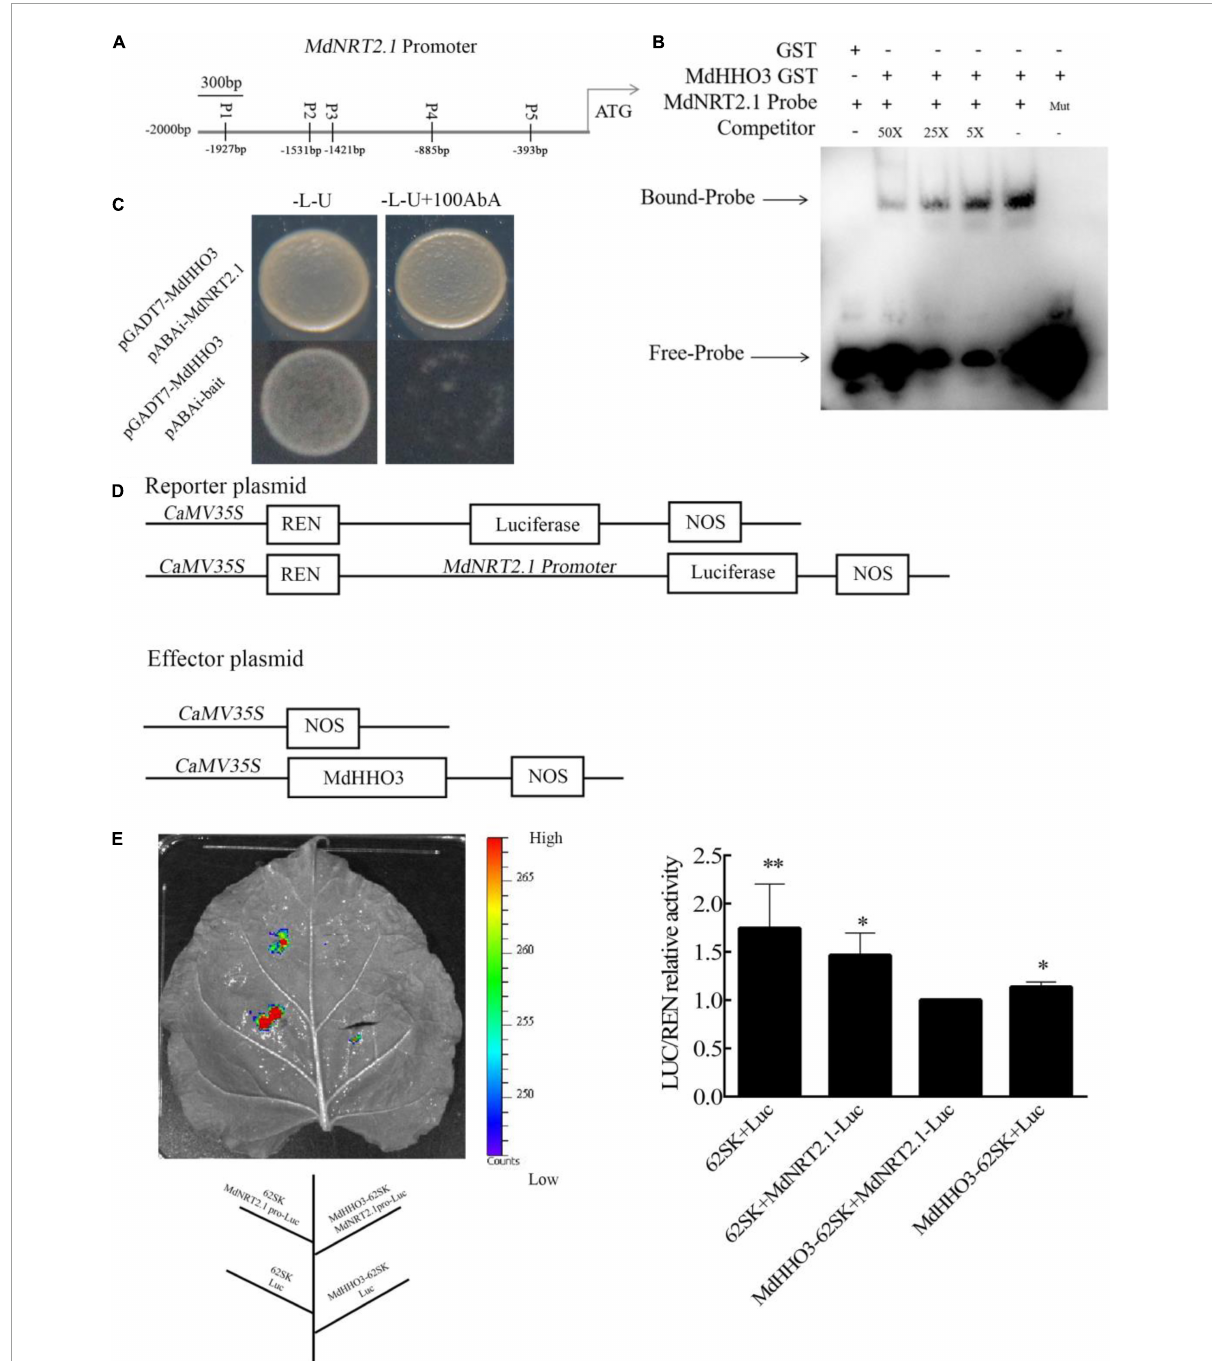
FIGURE7 MdHHO3 inhibits the expression of MdNRT2.1 . (A) Diagram of the MdNRT2.1 gene promoter region. p1–p5 represents the potential sites to which MdHHO3 may bind. (B) The electrophoretic mobility shift assay (EMSA) showed that the MdHHO3-GST fusion protein binds to the MdNRT2.1 promoter. The MdHHO3 fusion protein was incubated with a labeled or mutated probe DNA fragment. The labeled probe used in this study is p2 (5 (cid:48) -AACTCTTAAC GAATC AATGGATGGA-3 (cid:48) ). The unlabeled probes were used as a competitor. 50 × , 100 × , and 200 × represent the rates of the competitor. “Mut” representing the mutated probe in which the 5 (cid:48) -GAATC-3 (cid:48) motif was replaced by 5 (cid:48) -CAATG-3 (cid:48) . The – symbol indicates absence, and the + symbol indicates presence. (C) Yeast one-hybrid (Y1H) assay showing the interaction between MdHHO3 and the MdNRT2.1 promoter. The empty PGADT7 was used as a control. The fused yeast strains were grown on SD/-Leu/-Ura and SD/-Leu/-Ura + 100/200/400 mM AbA media. (D) Structure of the reporter and effector vectors used in the dual luciferase assays. (E) A transient expression assay of tobacco leaves showed that MdHHO3 inhibited the expression of MdNRT2.1 . Quantitative analysis of LUC/REN activity. An empty vector was used as the control. The data are expressed as the means ± SDs ( n = 3). Significant differences were detected by a t -test: * P < 0.05 and ** P <